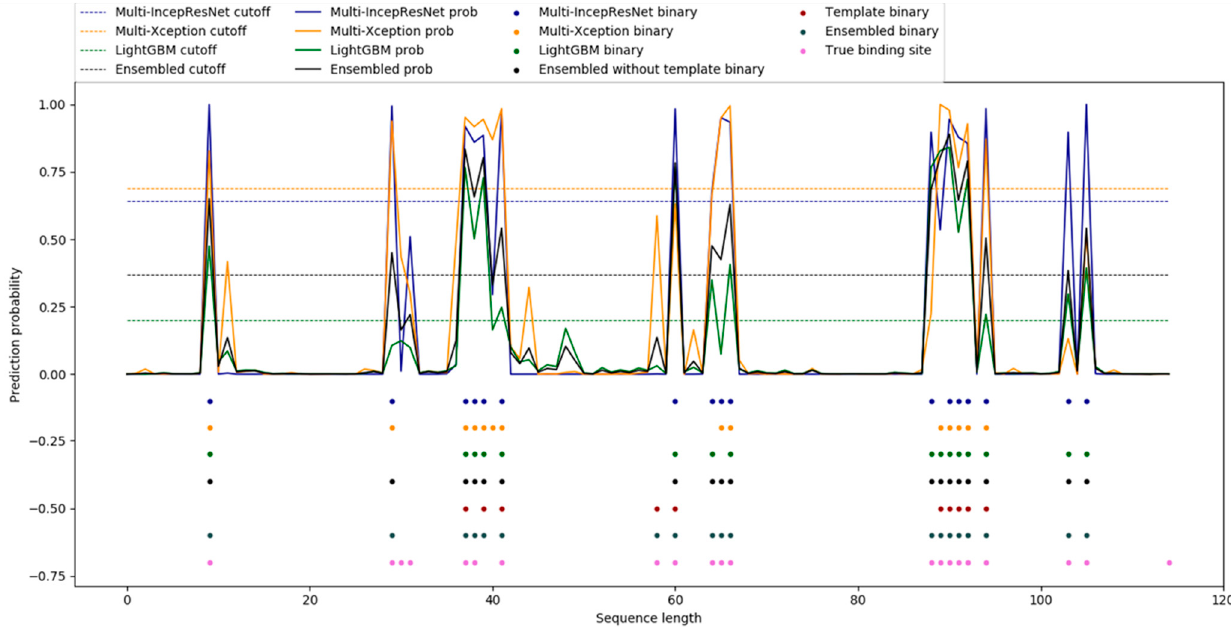
Figure 2. Binding residues predicted by the multi-IncepResNet-based predictor, multi-Xception-based predictor, LightGBM predictor, and the ensemble predictor for protein 4RX6_B. The x axis represents each residue in 4RX6_B and the y axis represents the probability predicted by the classifier. The blue, yellow, green, and black lines represent the probability curves of the multi-IncepResNet-based predictor, the multi-Xception-based predictor, the LightGBM predictor, and the ensemble predictor, respectively; the dots in the corresponding colors represent the binding residues predicted by the corresponding predictors. Specifically, the pink dots denote the observed (true) binding residues in the protein sequence, the red dots denote the predicted binding residues from the complementary template method, and the dots in slate-gray denote the predicted binding residues from the ensemble predictor complemented with the template method.